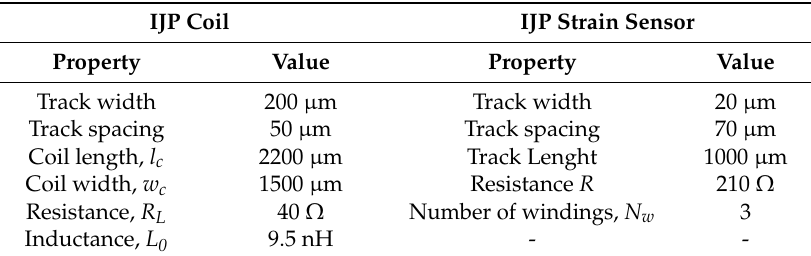
Figure 2. The IJP actuator. ( a ) Layout of the inkjet printed coil and strain gauge; ( b ) real view of the device. Table 3. Specifications of the printed devices.